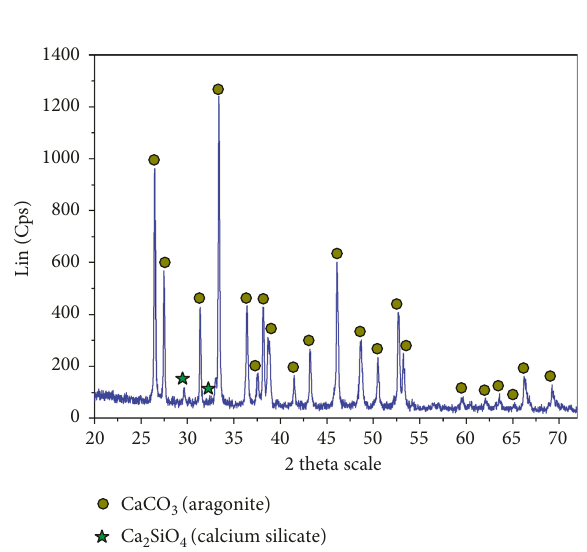
Figure 1: SEM images of FSS.